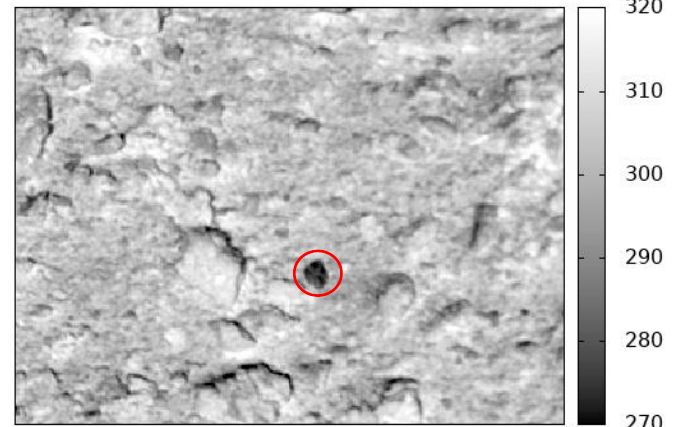
Figure 5. Close-up thermal image taken by TIR on 25 October 2018, during the descent operation of TD1-R3 Campaign. The width of this image is 20 m across. Most of boulders are the same temperature but a cold boulder (in a red circle) is seen as a “Cold Spot”. The temperature scale is in Kelvin. (Image: hyb2_tir_20181025_022416_l2.fit, © JAXA).